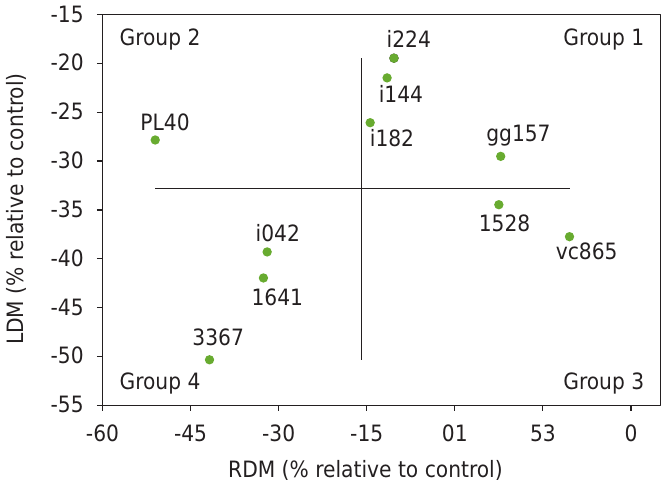
Figure 1. Distribution diagram of ten Eucalyptus clones according to the variation in leaf dry matter (LDM) and root dry matter (RDM) in response to drought stress, compared to LDM and RDM of well-watered plants.